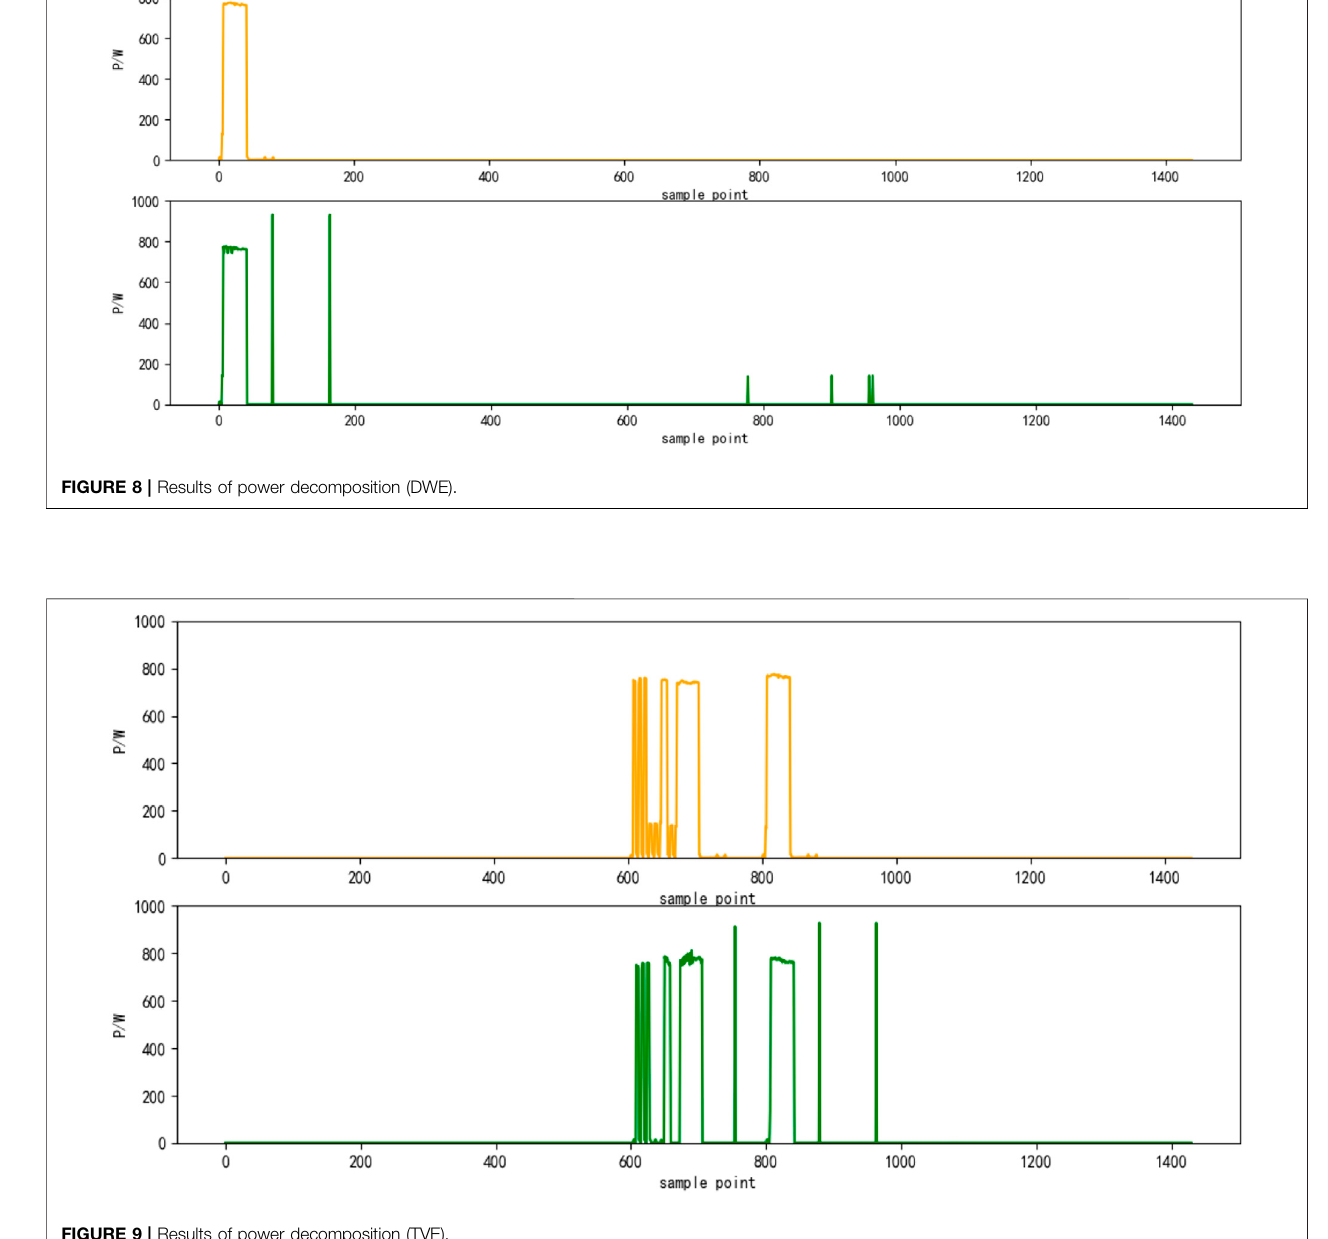
FIGURE 9 | Results of power decomposition